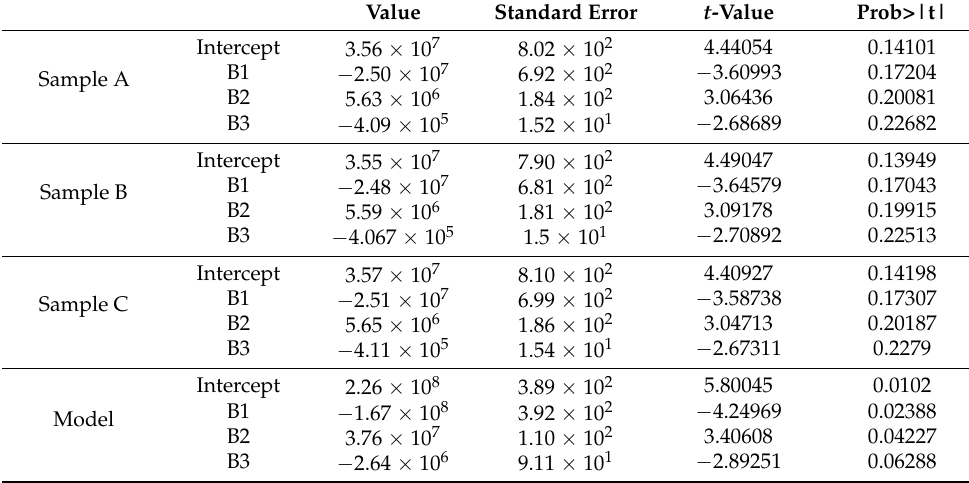
Table 6. Standard error and t-values for tension–tension fatigue samples.